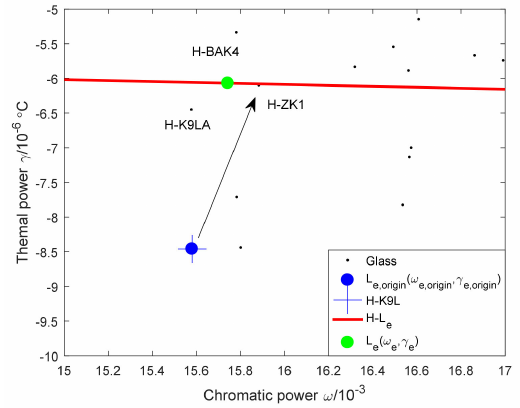
Figure 13. Athermal glass optimization